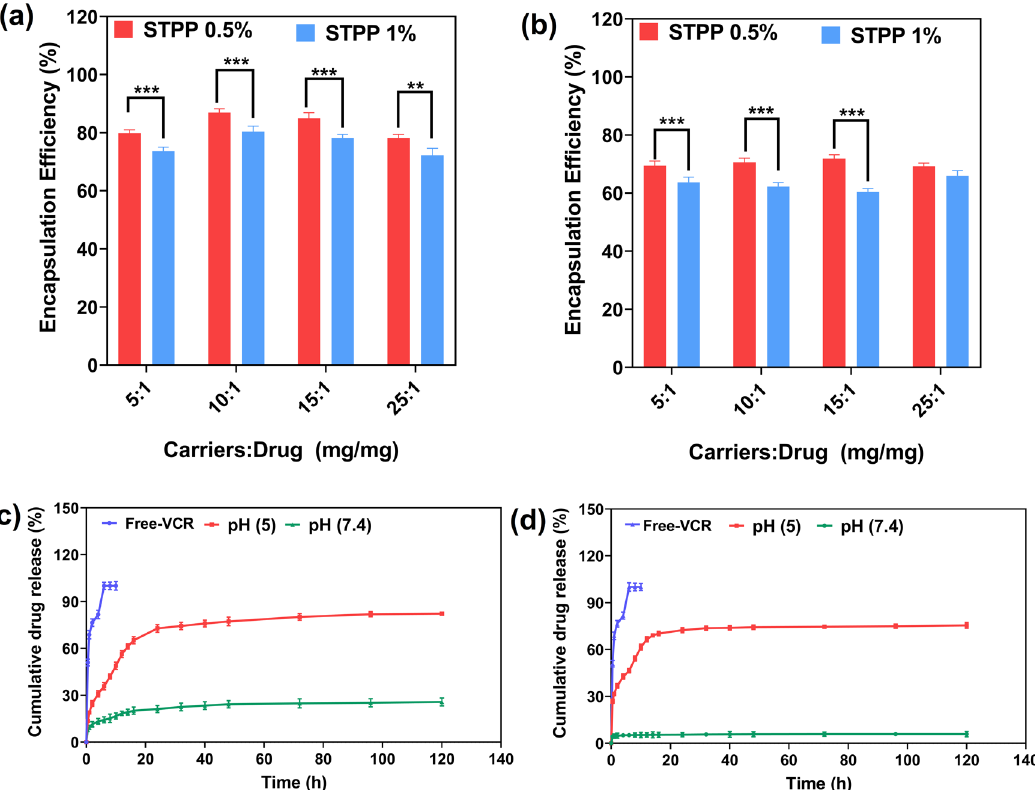
Fig. 10 Encapsulation ef fi ciency and drug release pro fi le of prepared hydrogels. Encapsulation ef fi ciency of ( a ) CS-g-gly and ( b ) CMCS-g-gly. Drug release pro fi le of ( c ) VCR/CS-g-gly and ( d ) VCR/CMCS-g-gly and free VCR in PBS (pH 7.4 and 5) after 120 h. Each value represents the mean ± SD of three independent